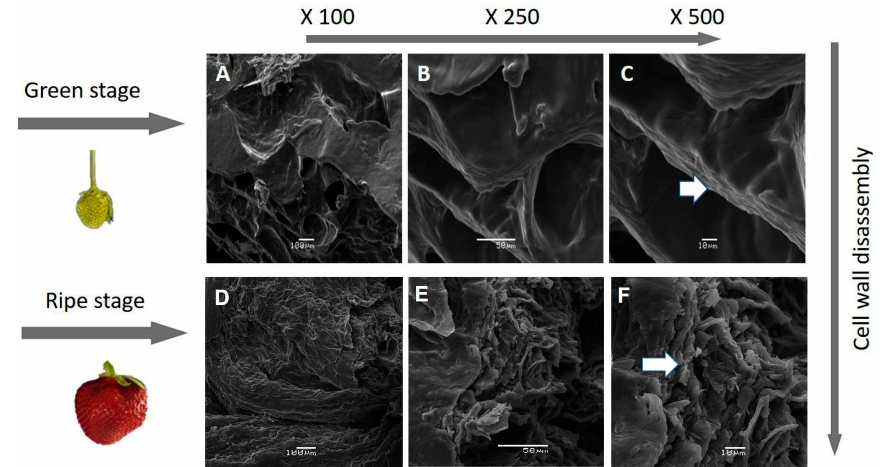
Figure 3. Scanning electron micrographs (SEM) of F. x ananassa ‘Camarosa’. ( A – C ): Green stage; ( D – F ): Ripe stage. The white arrow showed the disassembly of the cellulose-hemicellulose fraction.